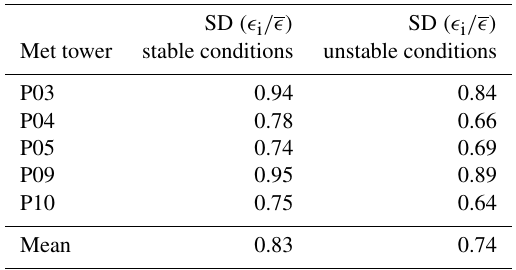
Table 3. Standard deviation of the distribution of the ratios between (cid:15) i from each sonic anemometer and the average (cid:15) from all five sonic anemometers for different atmospheric stability conditions.